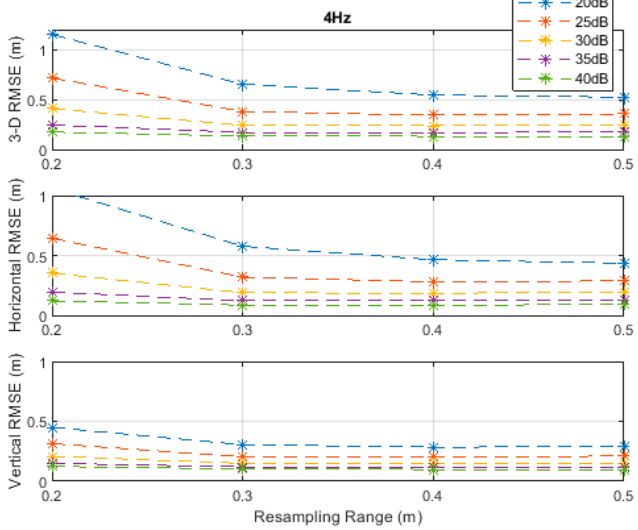
Figure 15. RMSE results along the helical path at a measurement update rate of 4 Hz. Table 5. Best accuracies obtained at all investigated SNR levels and measurement update rates in the helical path experiments.